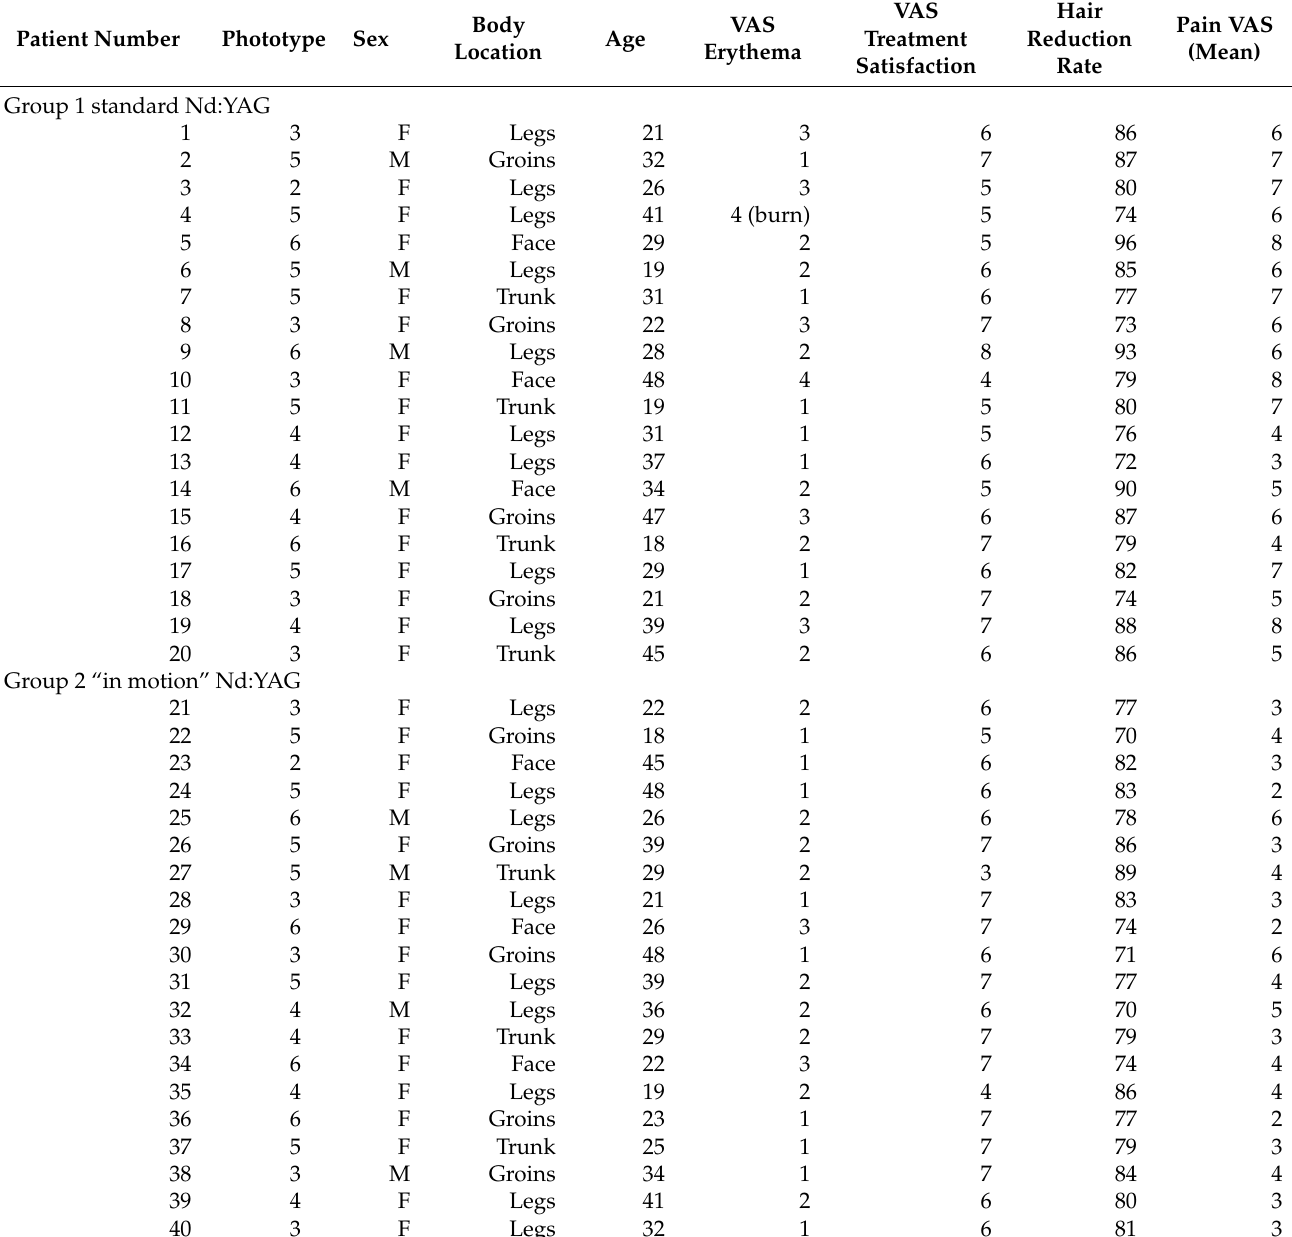
Table 1. Patient